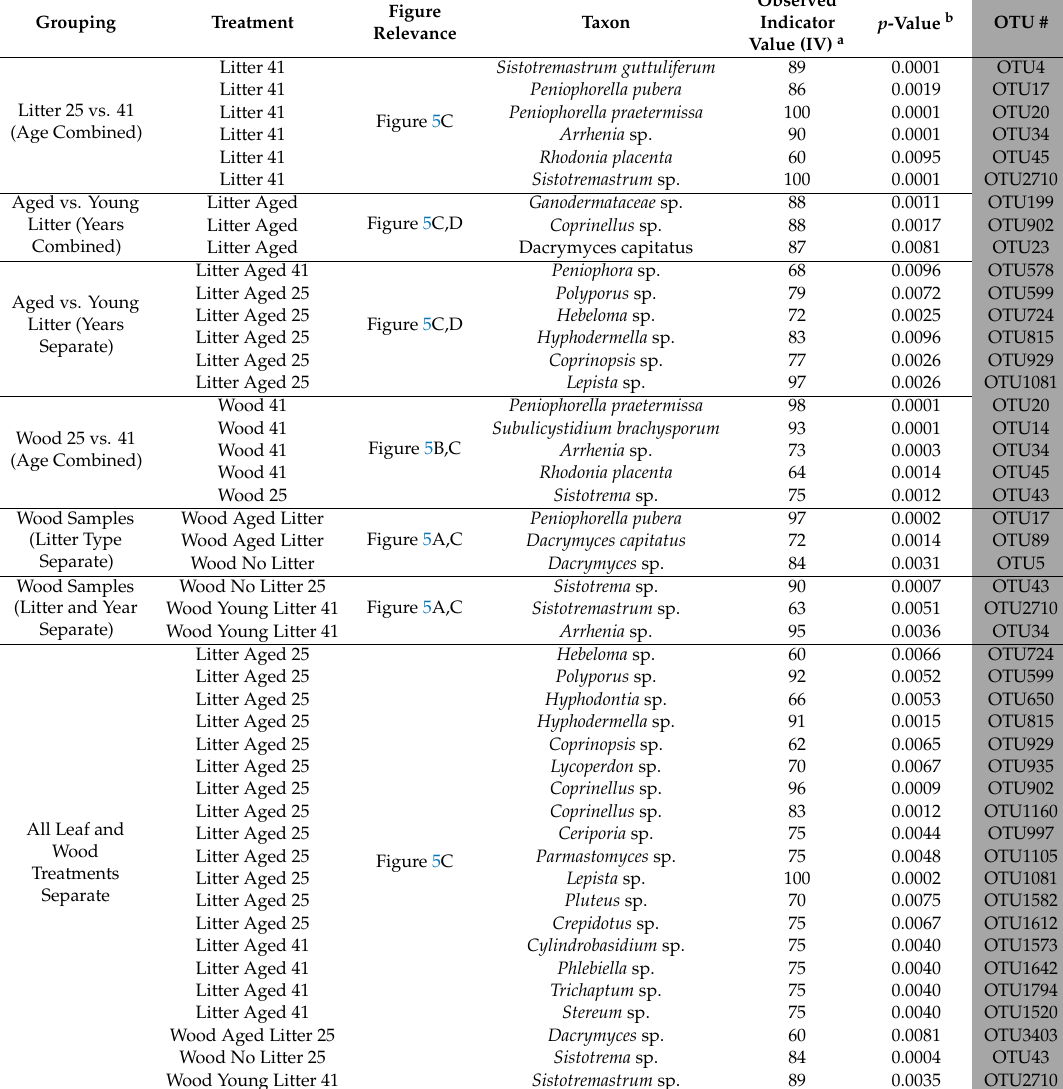
Table 3. Community analysis results grouped with Indicator species analysis results. Grouping